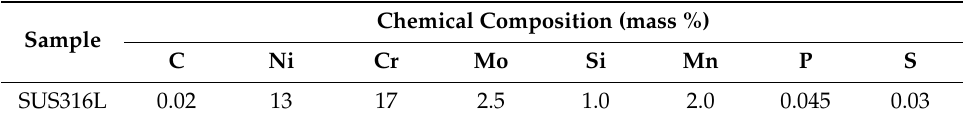
Table 1. Chemical composition of